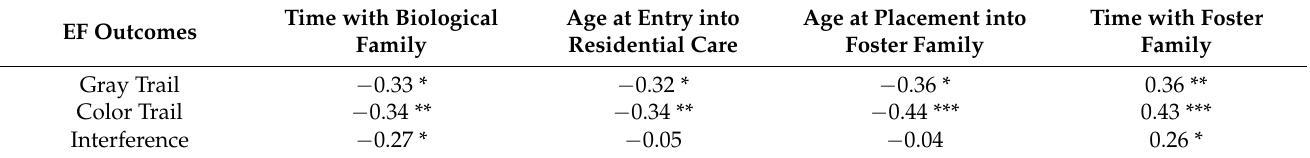
Table 2. Correlations between executive function outcomes and placement history. Time with Biological Age at Entry into Age at Placement into Time with Foster EF Outcomes Family Residential Care Foster Family Family Gray Trail − 0.33 * − 0.32 * − 0.36 * 0.36 ** Color